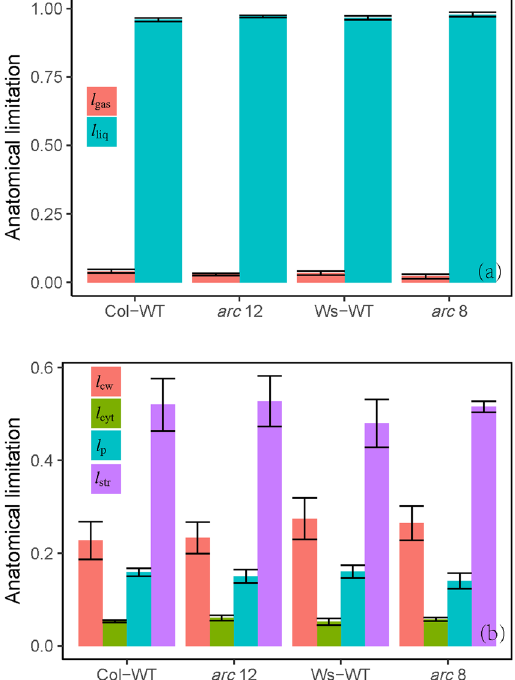
Figure 5. Limitation of mesophyll conductance due to anatomical constraints. ( a ) Share of the overall g m limitation by gas ( l gas ) and liquid phase ( l liq ) and ( b ) the liquid-phase limitation among its components: cell wall ( l cw ), cytosol ( l cyt ), plasmalemma and chloroplast envelope membranes ( l p ), and chloroplast stroma ( l str ). The l ias was calculated as g m / g ias and the liquid-phase limitations of each components were calculated as l i = g m /( g i · S c